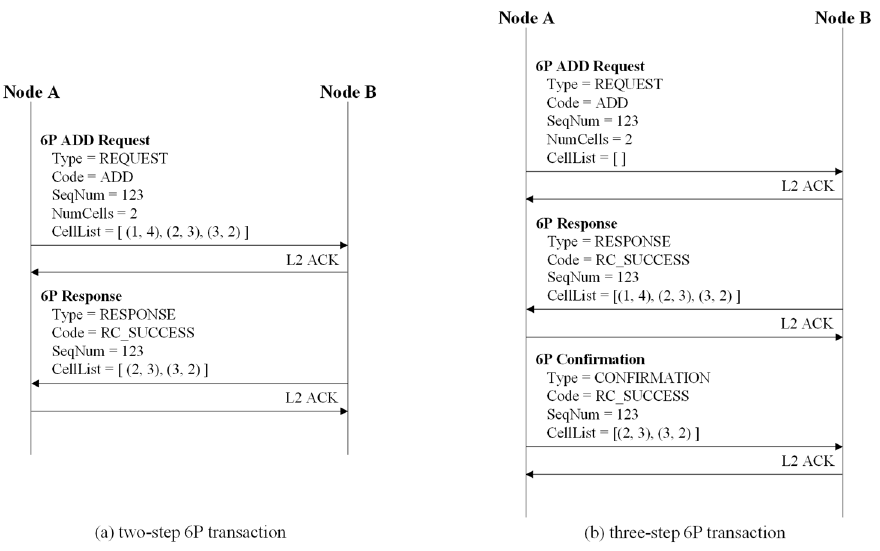
Figure 2. Example of two-step and three-step 6P transactions.